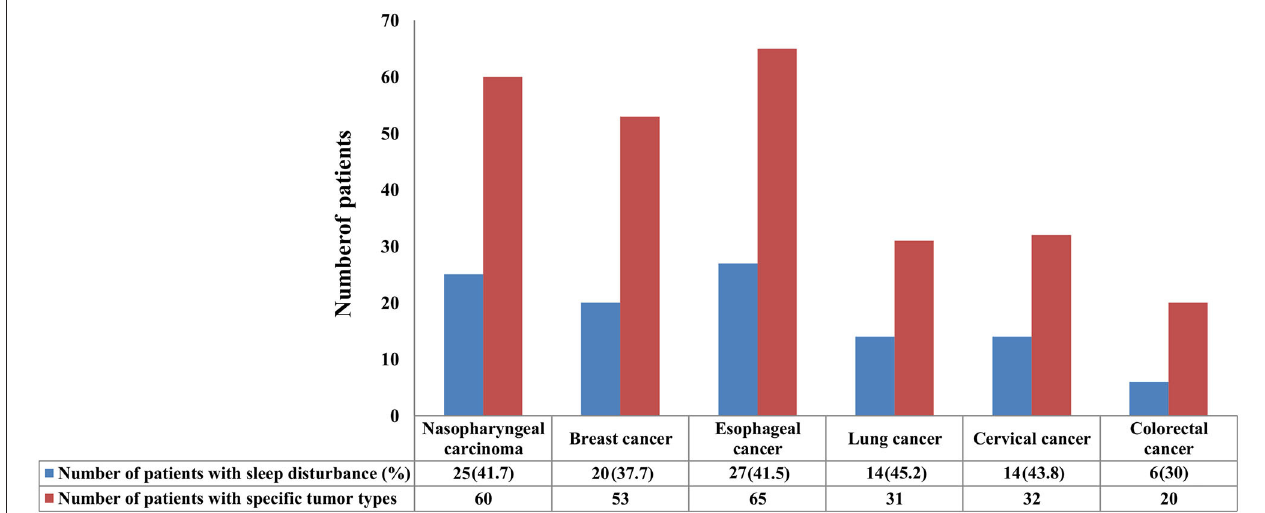
FIGURE 1 | The incidence of sleep disturbance in patients with specific tumor